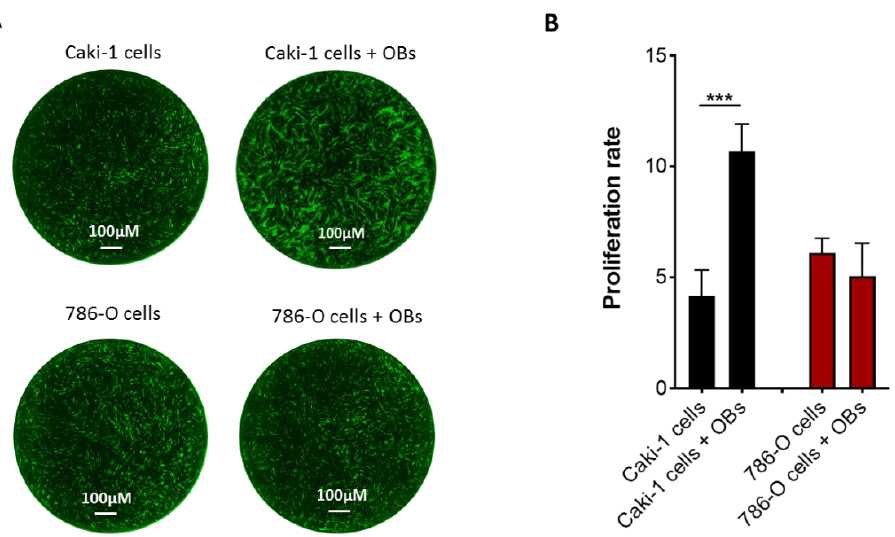
Figure 2. Effects of OBs on metastatic RCC cell proliferation. ( A ) Representative images of Caki-1 GFP+ (green) and 786-O GFP+ cells (green) cultured alone or with OBs. Scale bar: 100 μM and magnification 4×. ( B ) Proliferation rate analysis of Caki-1 GFP+ and 786-O GFP+ cells in a monoculture or cocultured with OBs. Data are expressed as the mean ± SD; *** p ˂ 0.001 .